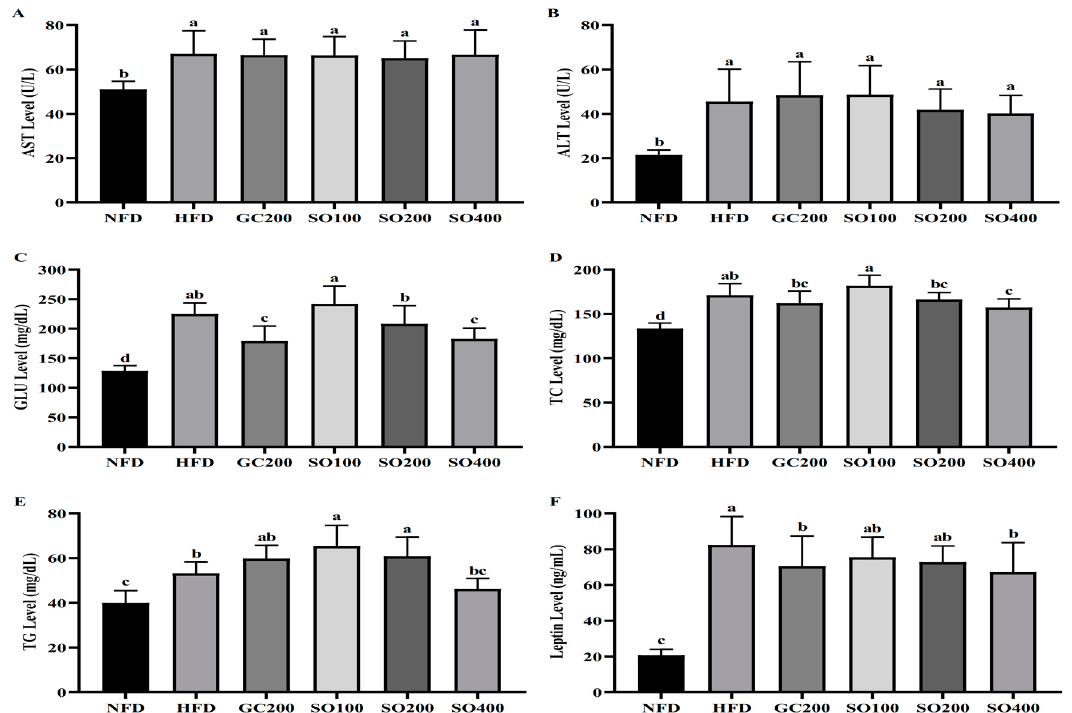
Figure 7. Effects of SO on serum biochemical parameters in HFD-induced obese mice: ( A ) serum aspartate aminotransferase (AST) level; ( B ) serum alanine aminotransferase (ALT) level; ( C ) serum glucose level (GLU) level; ( D ) serum total cholesterol (TC) level; ( E ) serum triglyceride (TG) level; ( F ) serum leptin level. GC200, HFD supplemented with 200 mg/kg/day of GC; SO100, HFD supplemented with 100 mg/kg/day of SO; SO200, HFD supplemented with 200 mg/kg/day of SO; SO400, HFD supplemented with 400 mg/kg/day of SO. Values are expressed as mean ± SD of experiments. Different letters indicate significant differences at the level of p < 0.05.